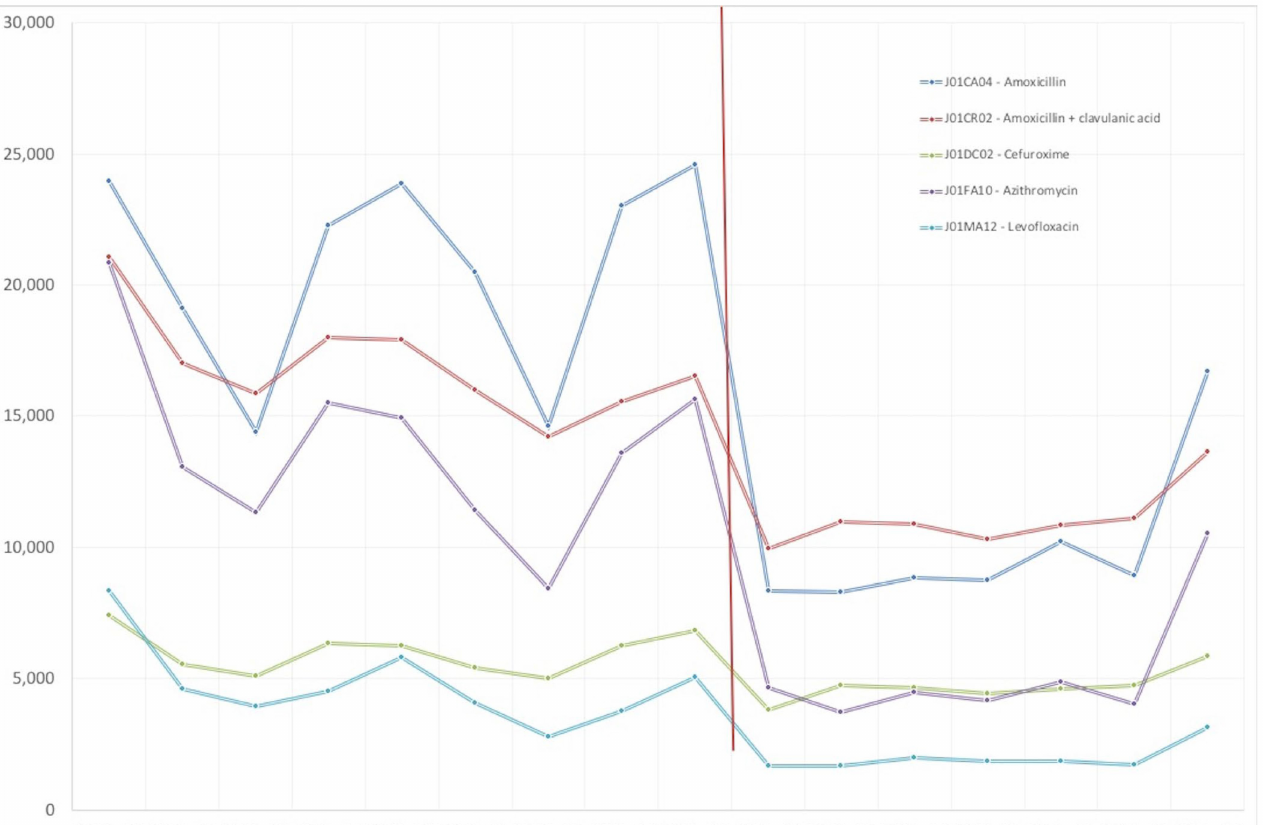
Figure 3. Patients treated with considered critical antibiotics among the years 2018 and